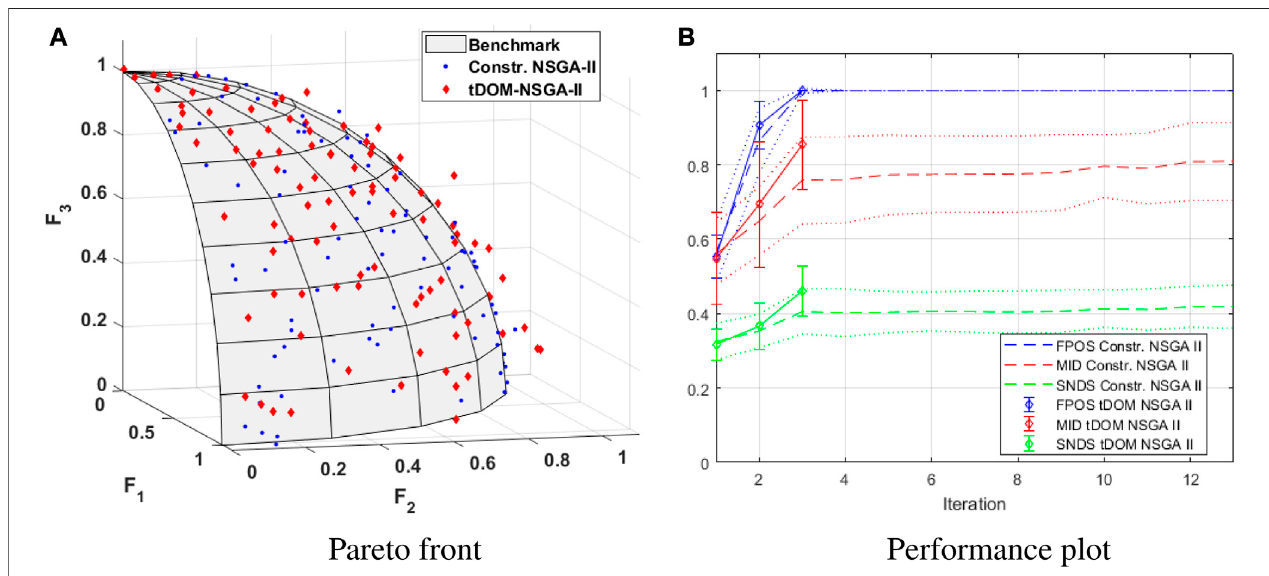
FIGURE 9 | Pareto front (A) and performance plot (B) of the DTLZ2.3-problem, generated via tDOM-NSGA-II.